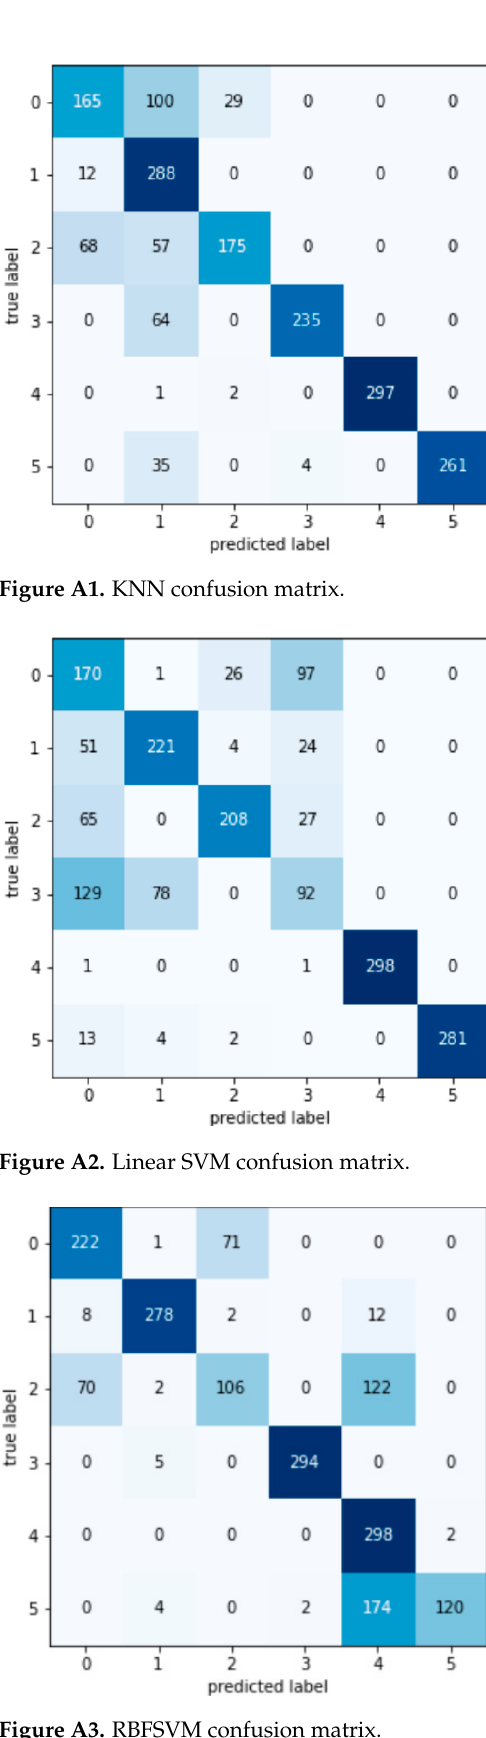
Figure A4. Decision tree SVM confusion matrix. Figure A5. Adaboost confusion matrix.